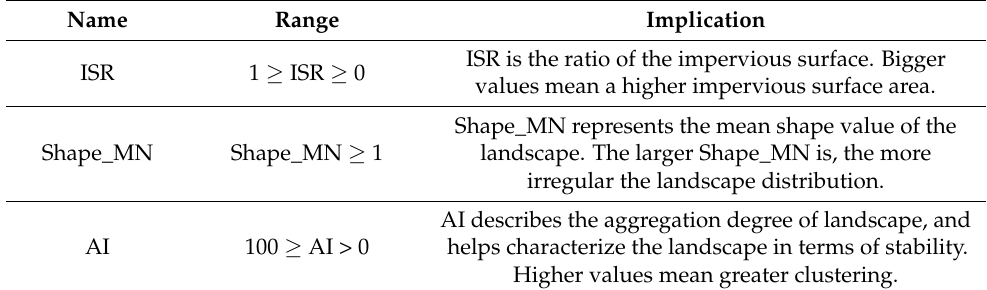
Table 2. Overview of indices used in the current